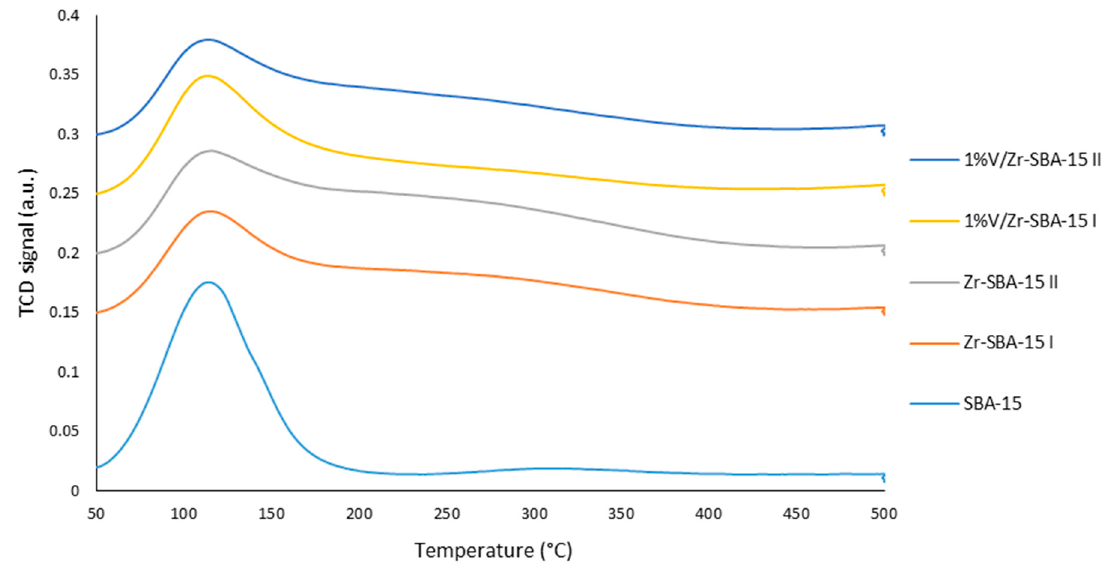
Figure 6. Temperature ‐ programmable desorption of ammonia (NH3 ‐ TPD) profiles of catalysts.